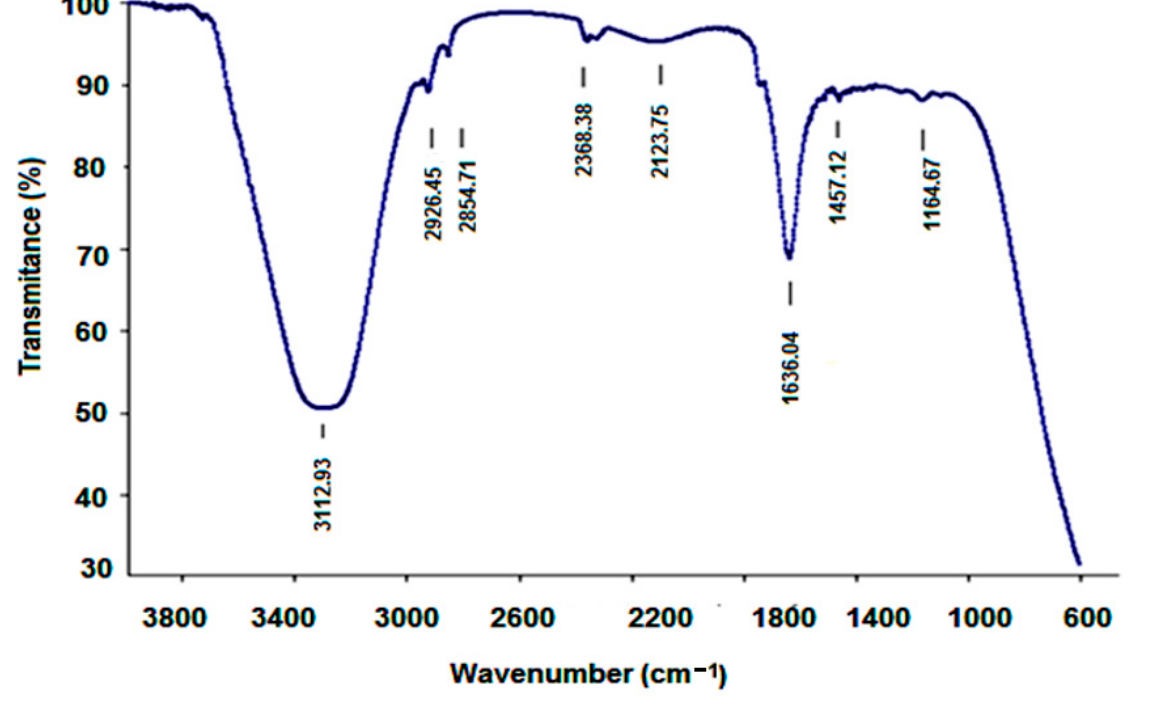
Figure 9. ATR − FTIR pattern of the synthesized A-IONPs. Figure 9. ATR-FTIR pattern of the synthesized A-IONPs. The broad absorption peak at 3312.93 cm − 1 (Figure 9) can be attributed to